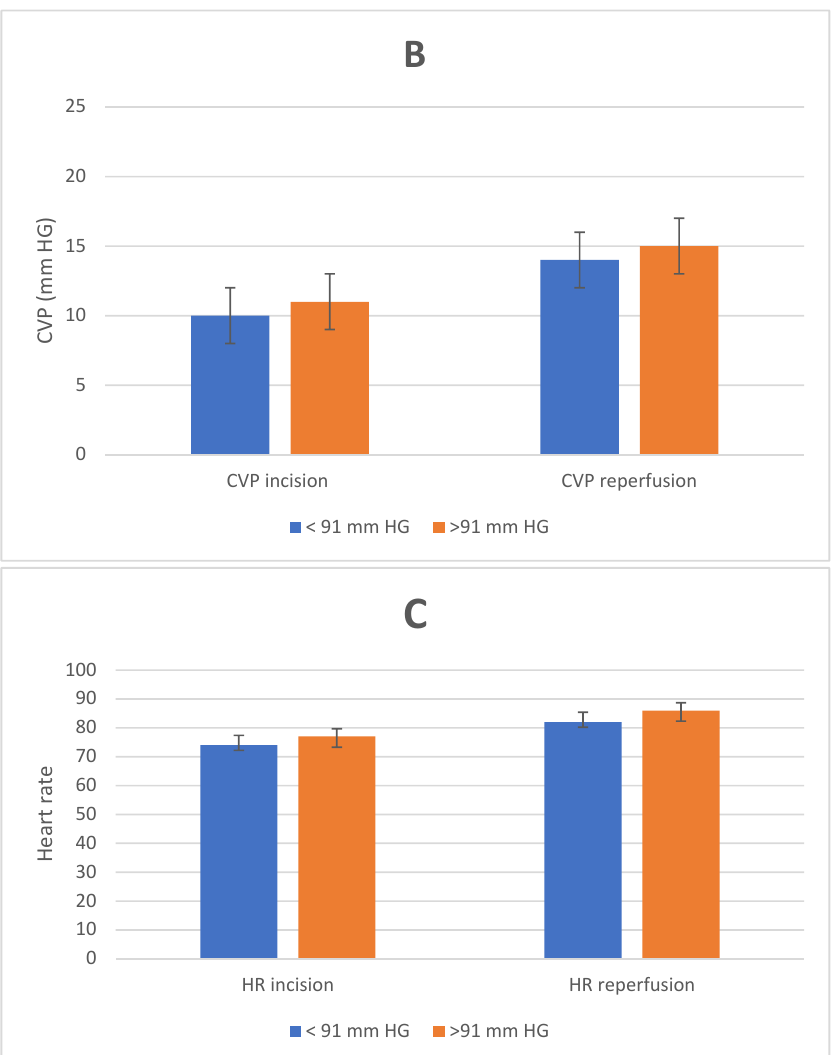
Figure 1. Intraoperative hemodynamic measurements: ( A ) mean arterial pressure (MAP); ( B ) central venous pressure (CVP); ( C ) heart rate (HR).